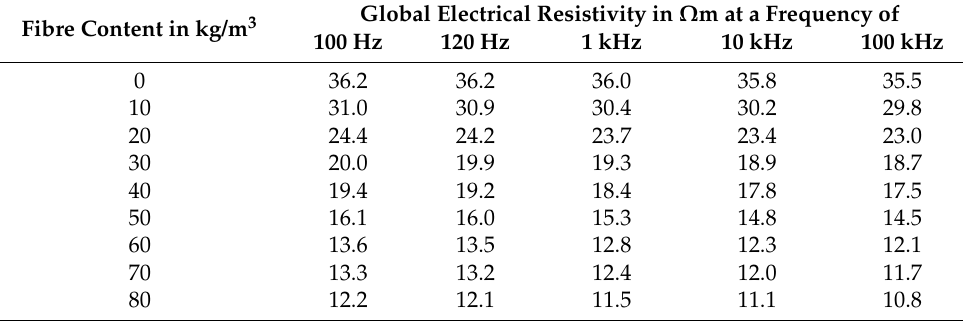
Table A32. Results of the resistivity measurements of the concrete mixture